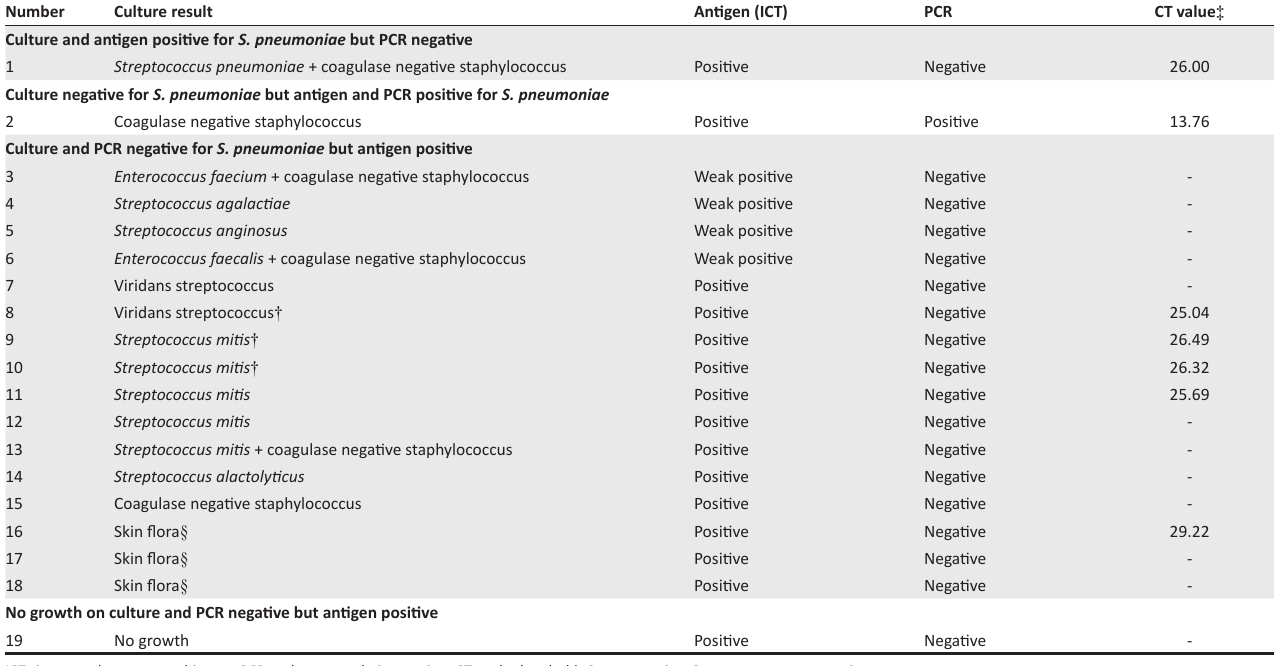
TABLE 1: Discordant results between the antigen test (immunochromatographic test), polymerase chain reaction and culture. Number Culture and antigen positive for S. pneumoniae but PCR